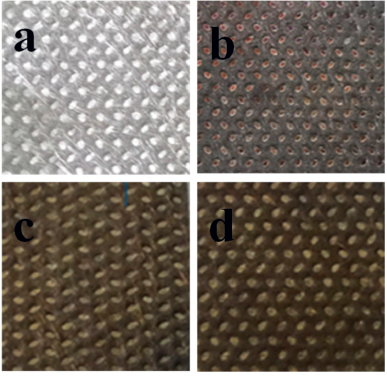
Figure 10. The color change of the fabric before and after the treatment of Na 2 S: ( a , b ) Ag-coated PP nonwoven before and after Na 2 S treatment; ( c , d ) PDA deposited (12 h) on the Ag-coated PP nonwoven before and after Na 2 S treatment.